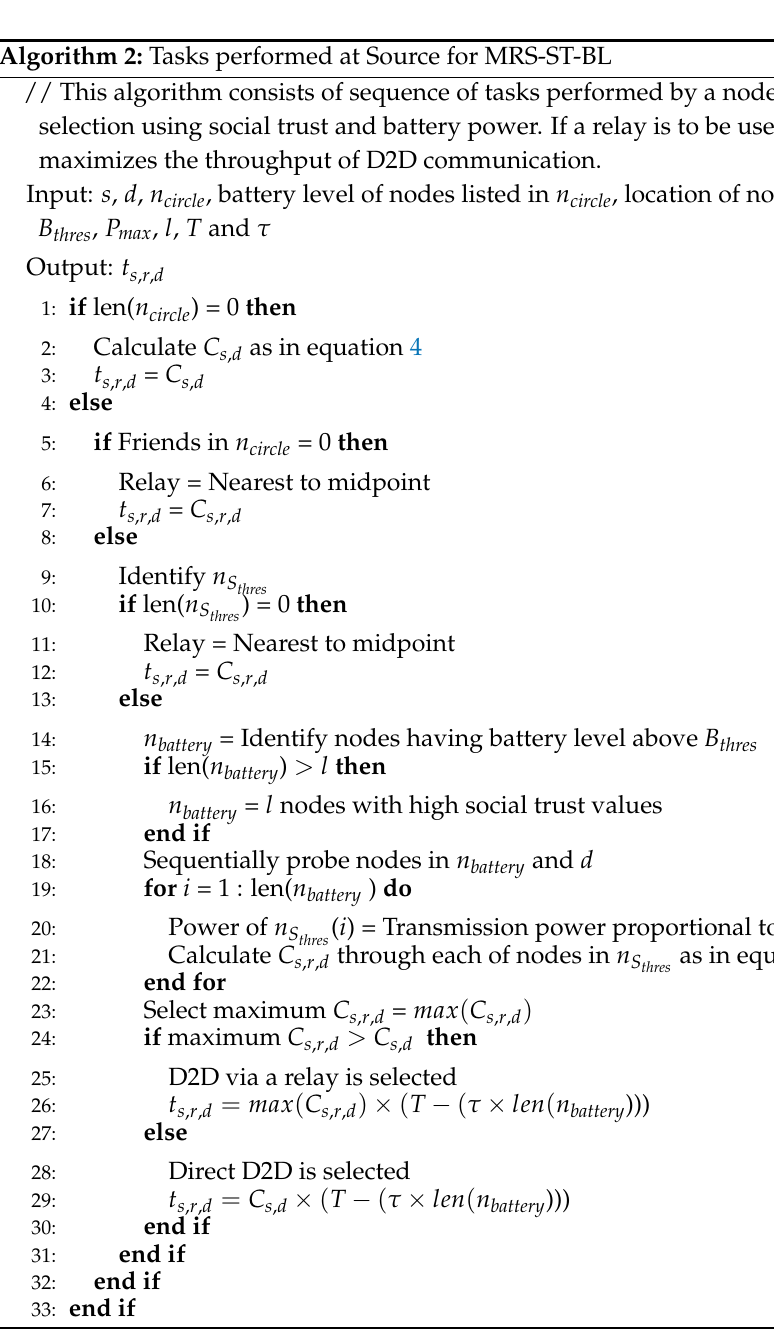
Algorithm 2: Tasks performed at Source for MRS-ST-BL // This algorithm consists of sequence of tasks performed by a node for midpoint relay selection using social trust and battery power. If a relay is to be used, it selects a relay that maximizes the throughput of D2D